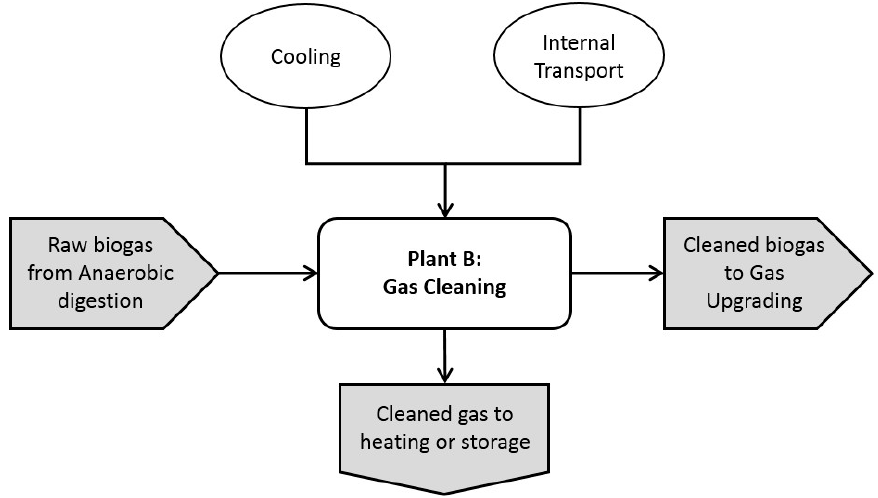
Figure 9. The connection between the sub-process gas cleaning and unit processes at biogas plant B.